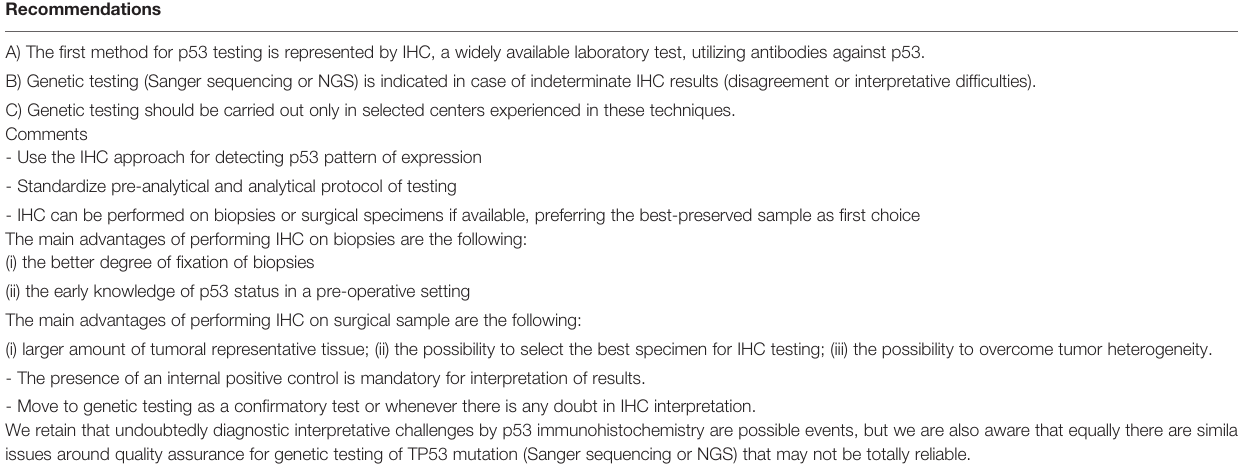
TABLE 3 | P53: recommendations and comments from the working group.